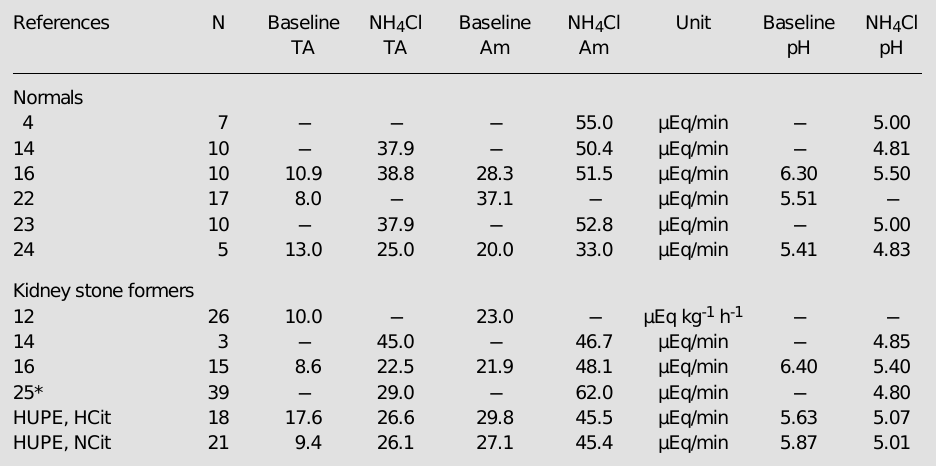
Table 2 - Titratable acidity (TA) and ammonium (Am) excretion in the basal state and after NH 4 Cl administra- tion. *Backman et al. used a dose of 0.2 g/kg of NH 4 Cl. In the other studies a dose of 0.1 g/kg was used. HUPE, Hospital Universitário Pedro Ernesto; HCit, hypocitraturia; NCit,